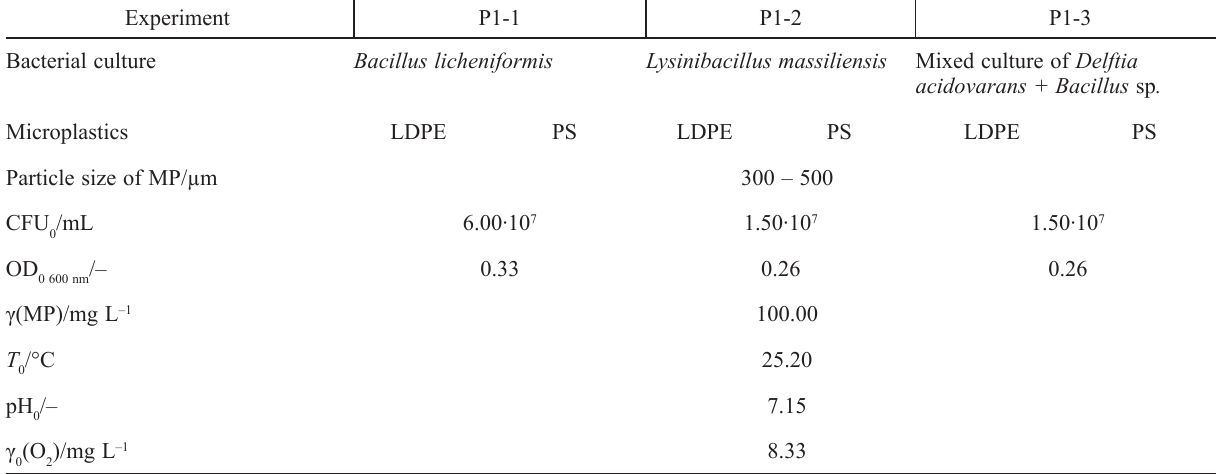
Table 1 – Initial conditions for biodegradation process